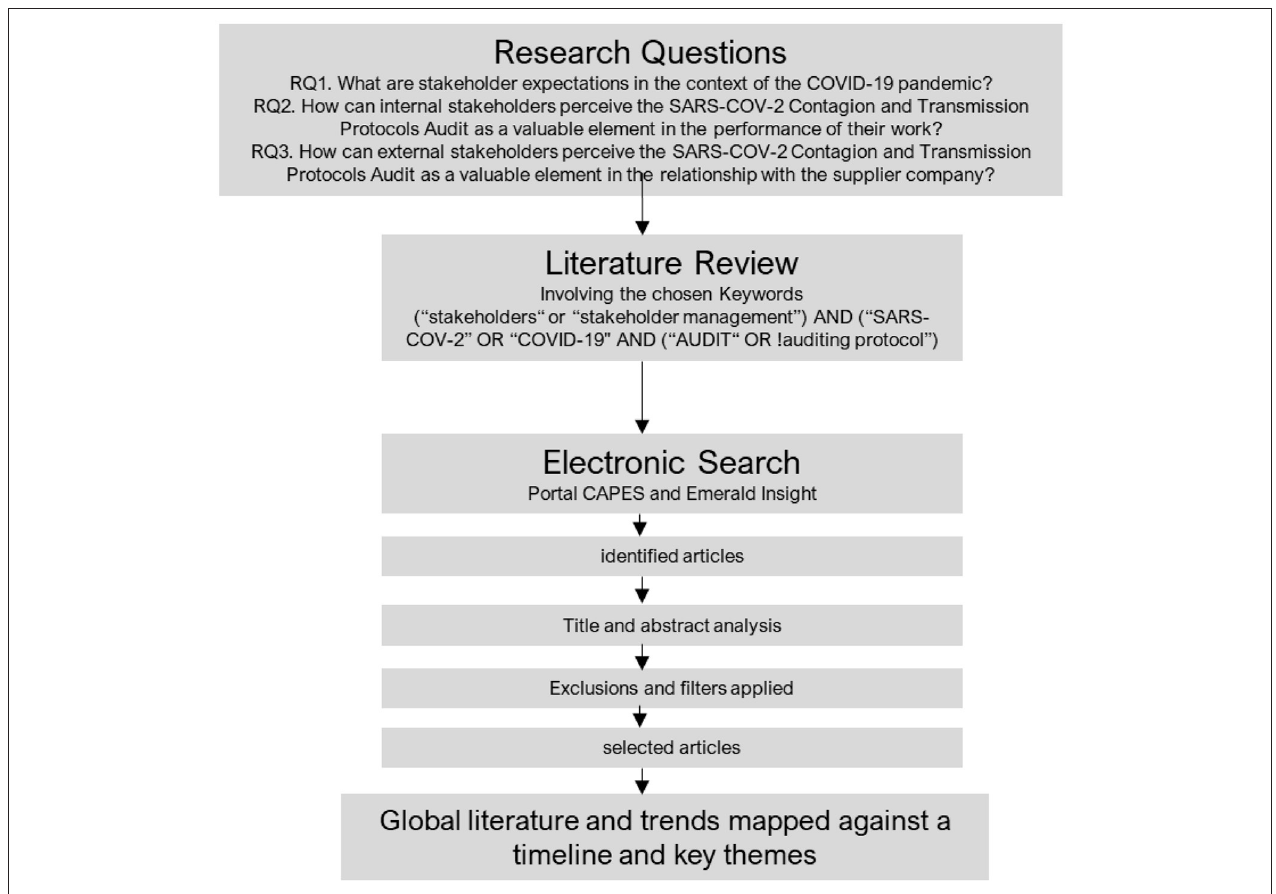
FIGURE 1 | Research